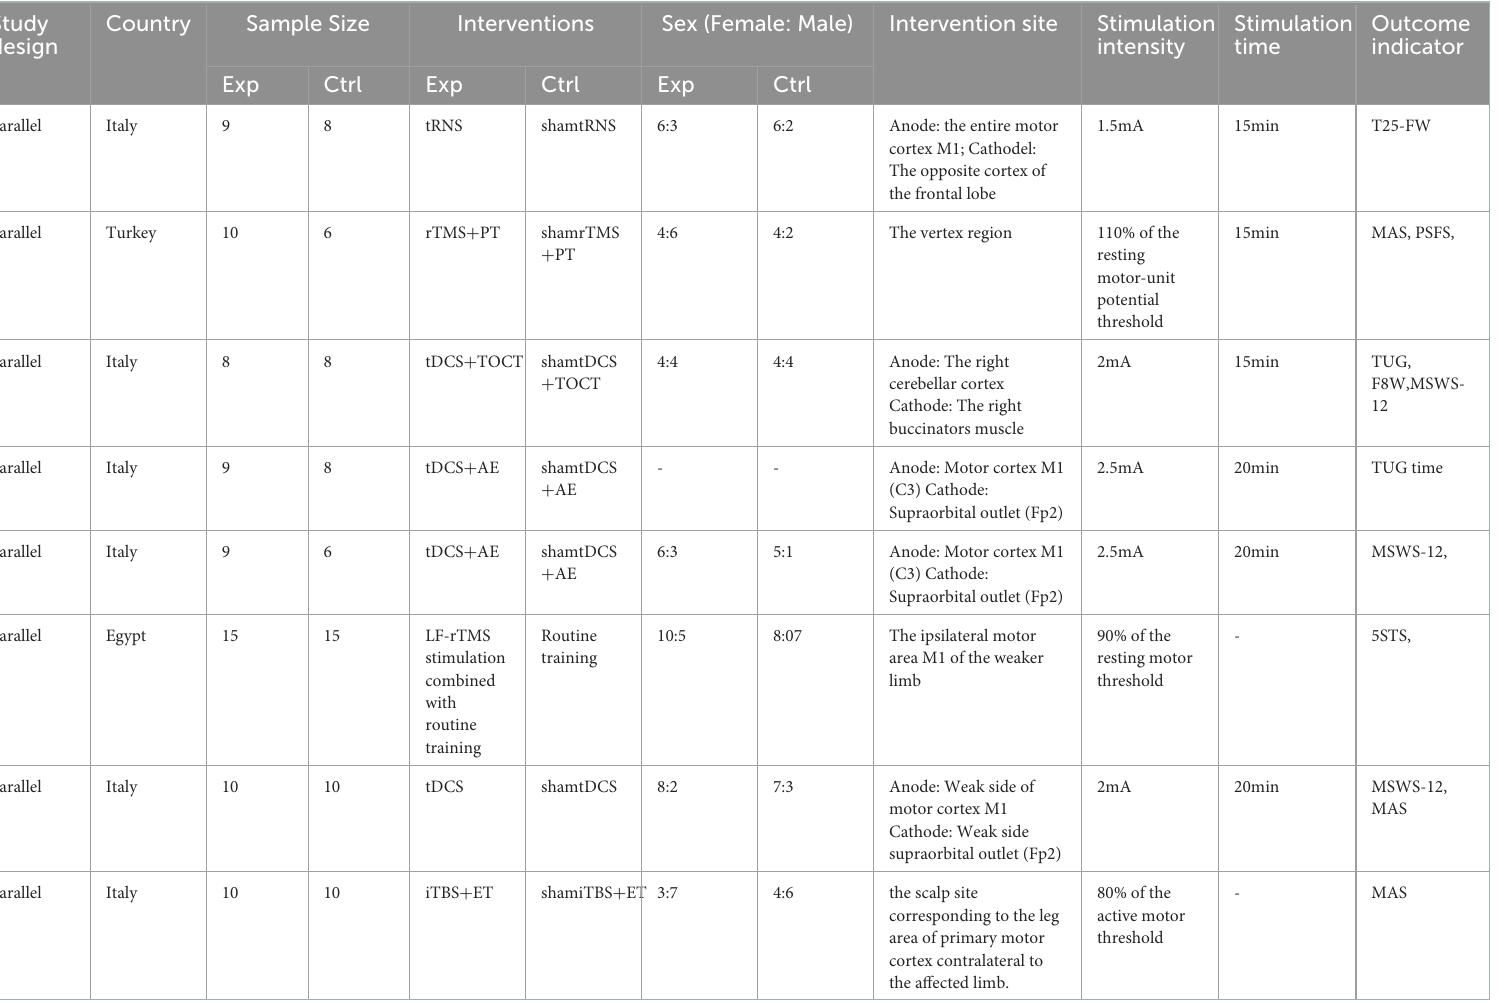
the scalp site corresponding to the leg area of primary motor cortex contralateral to the affected